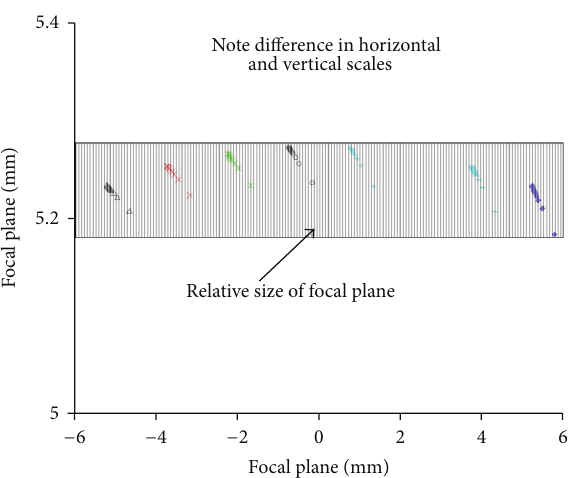
Figure8:UpperspotpatternsfromFigure 7.Notethecurvaturedue to distortion. The curvature is exaggerated in this figure by the dif- ferent vertical and horizontal scales.